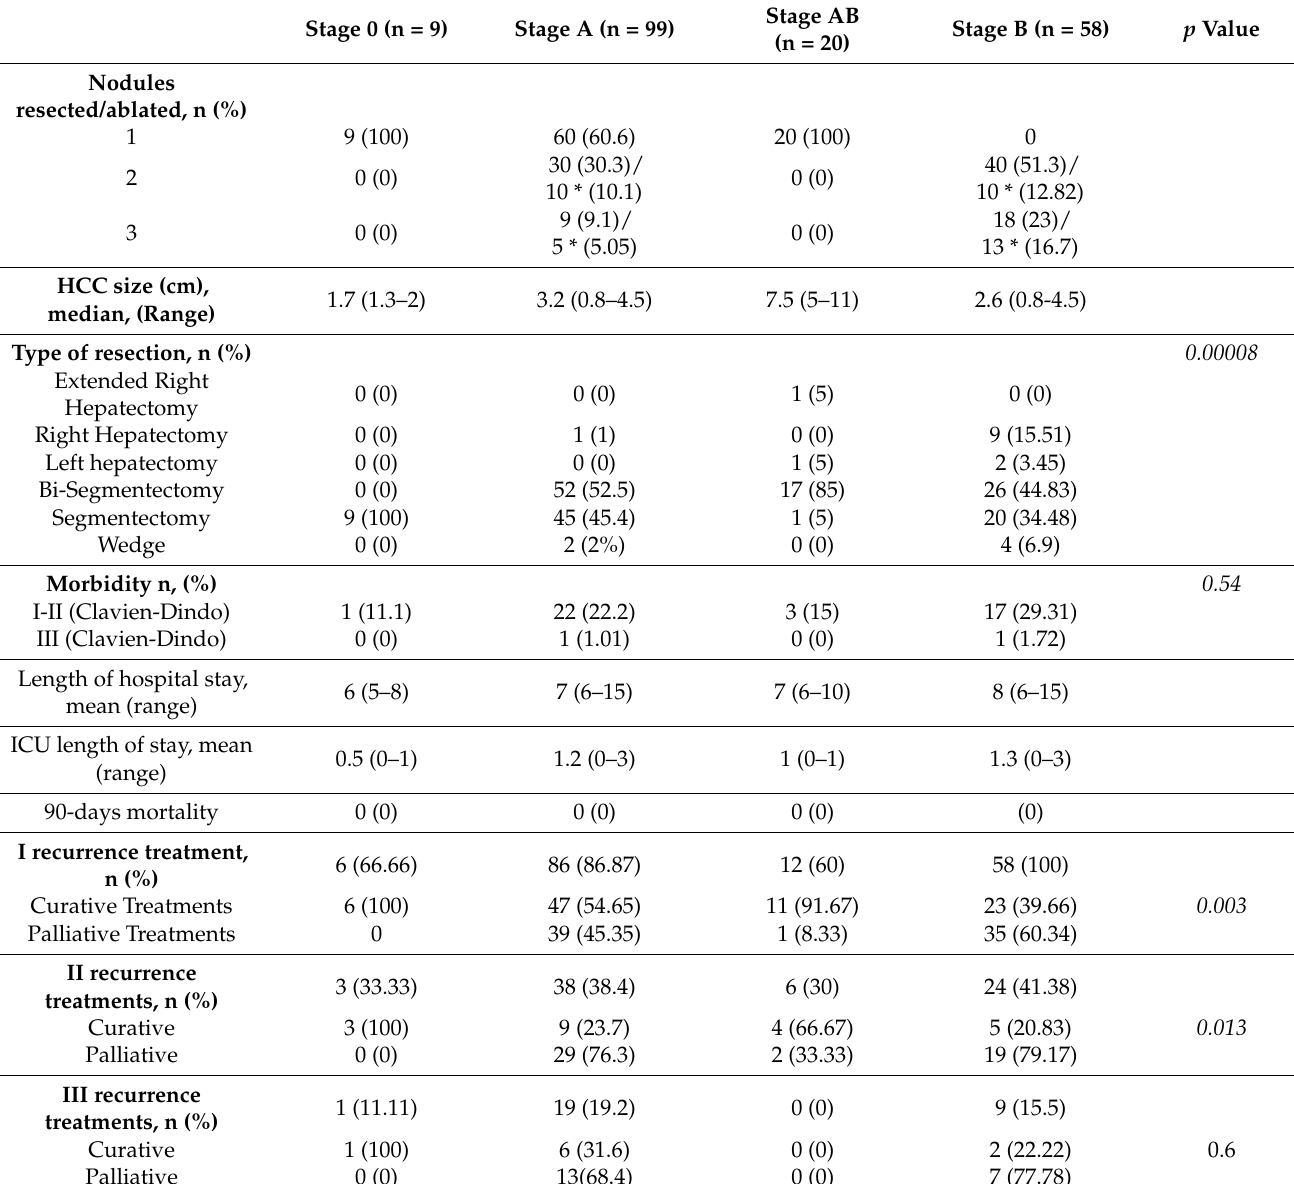
Table 2. Tumor features and treatments. Perioperative outcomes. Recurrence